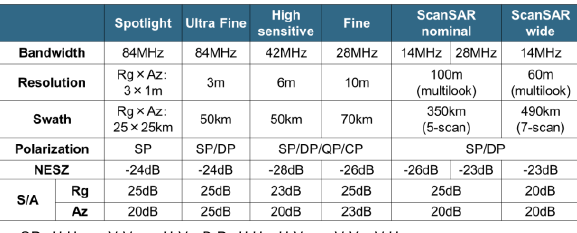
Table 2. PALSAR-2 observation modes and characteristics